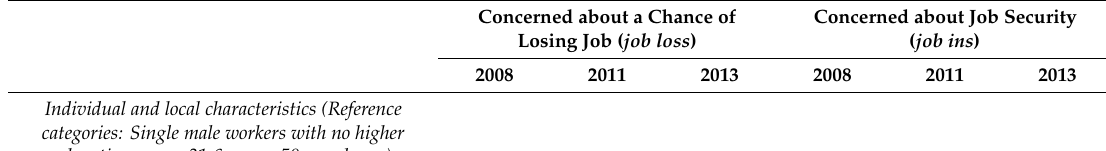
Table 2. Ordered probability unit (probit) estimates for degree of satisfaction with job security (job ins) and probability of losing job (job loss), by